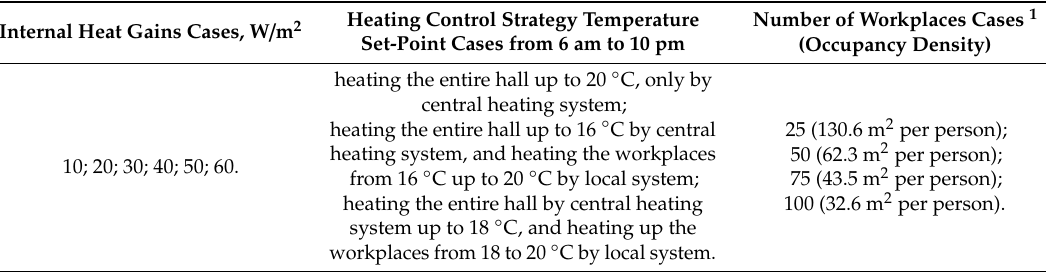
Table 2. Analyzed